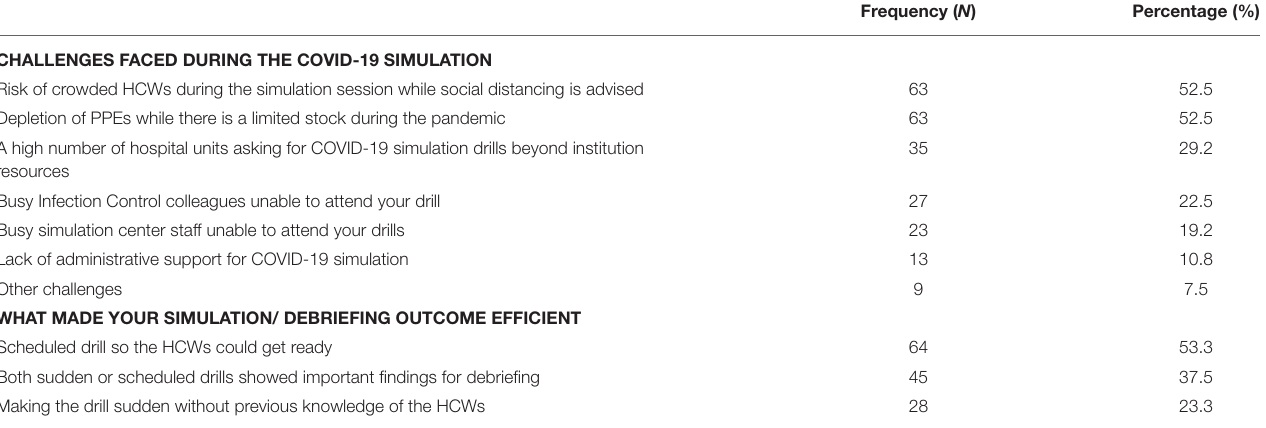
TABLE 5 | Respondents perceived challenges and potential facilitators for successful COVID-19